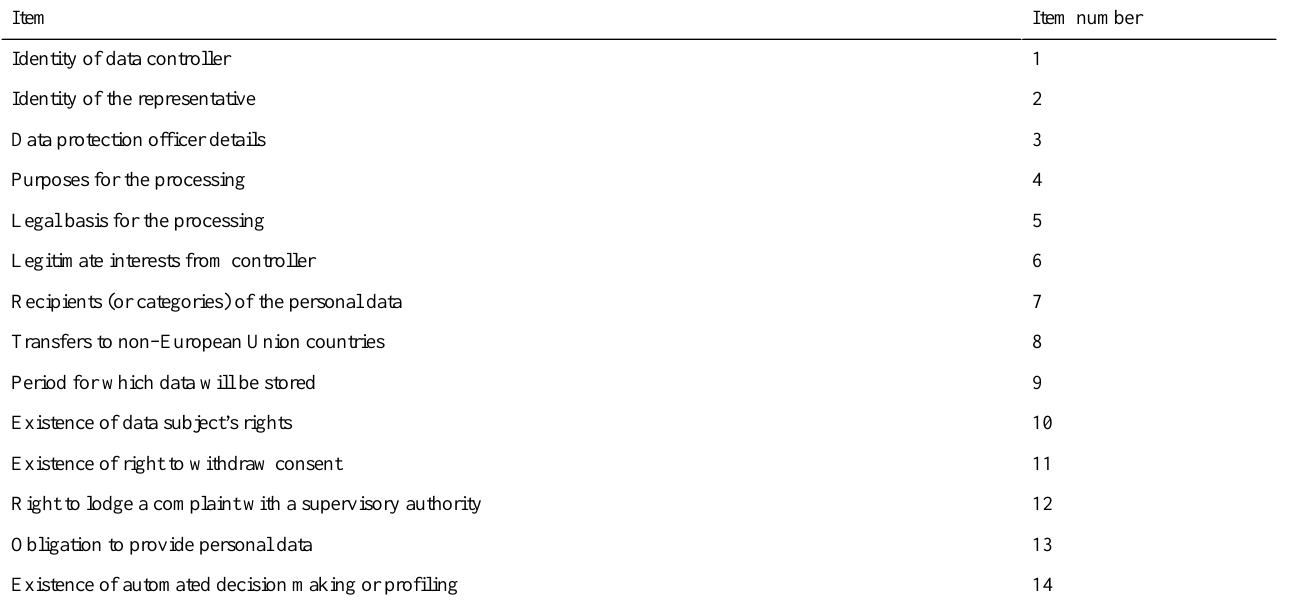
Table 2. Items in the privacy policy (Article 13).